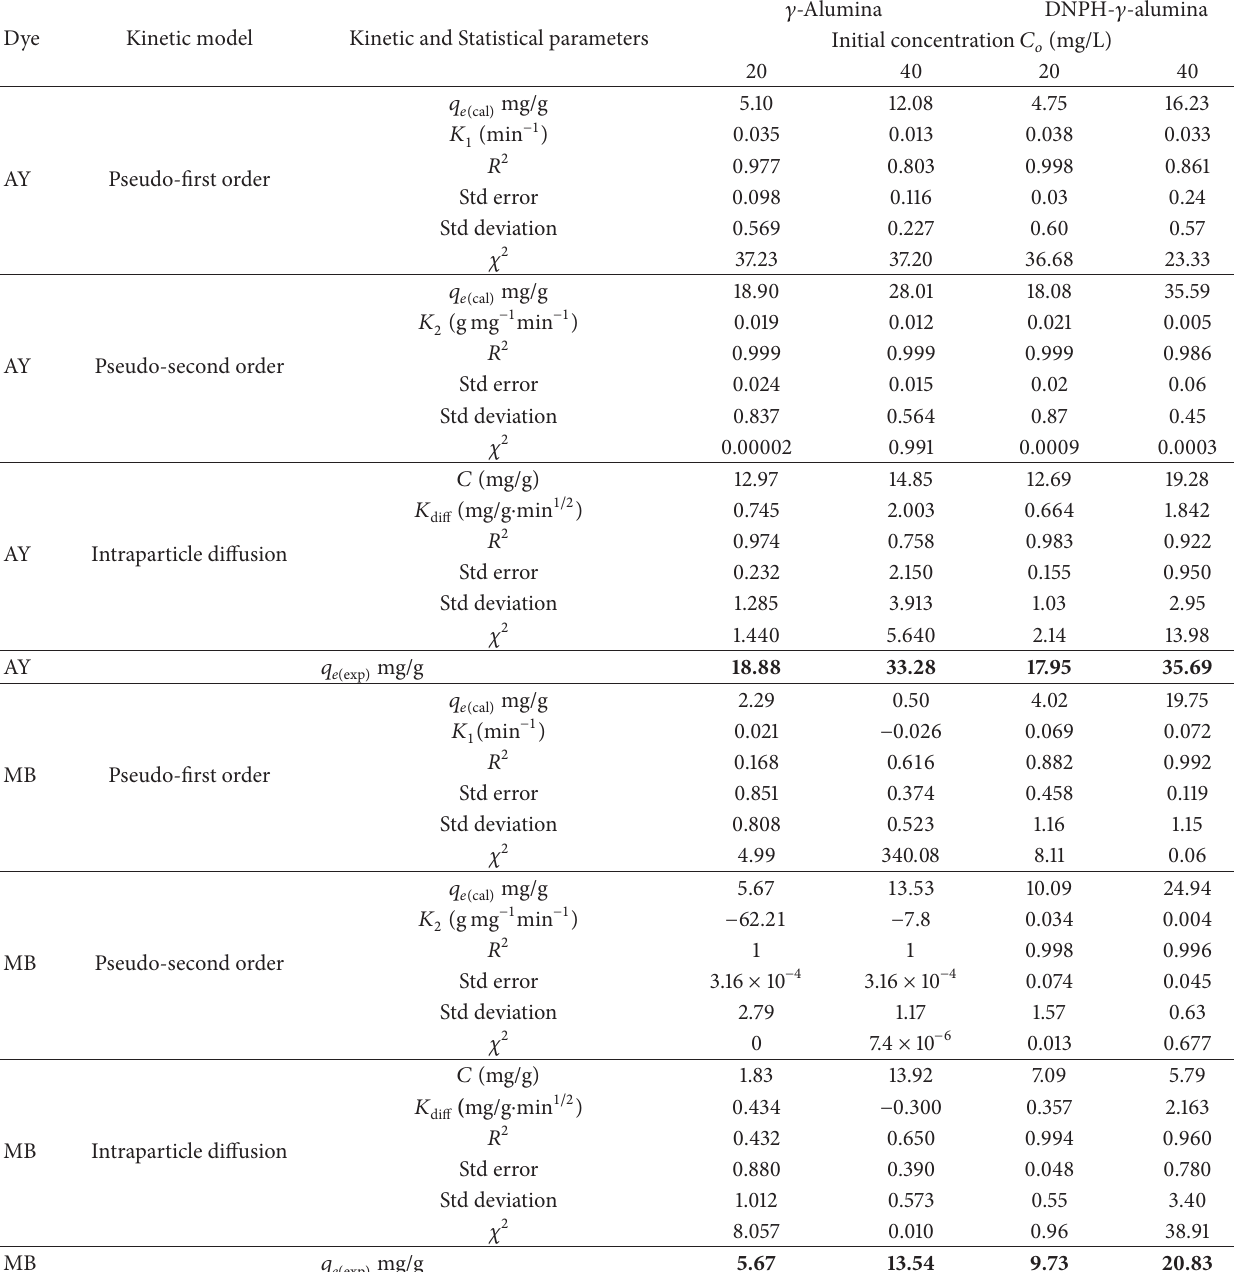
Table3:ComparisonofthekineticconstantsandstatisticalparametersfortheadsorptionofAYandMBon 𝛾 -aluminaandDNPH- 𝛾